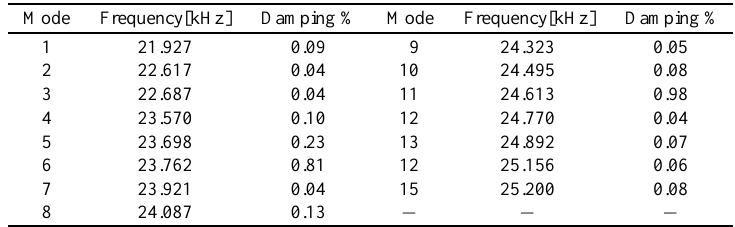
Table 1 The natural frequencies and the damping values for the accelerometer test